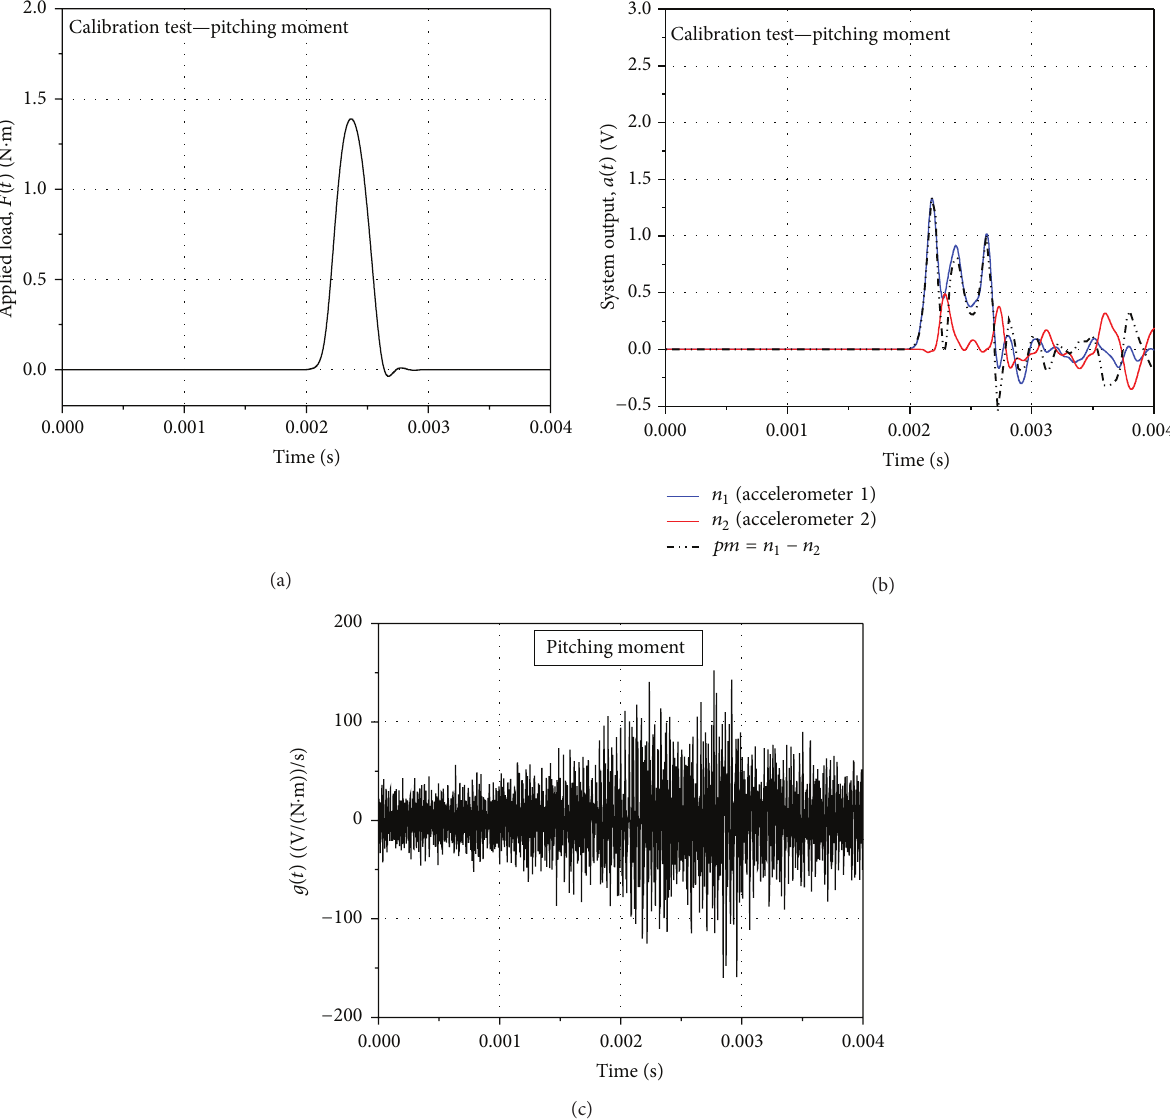
Figure 6: Typical signals of (a) applied load, (b) system output, and (c) impulse response function obtained during/through the dynamic calibration of the test